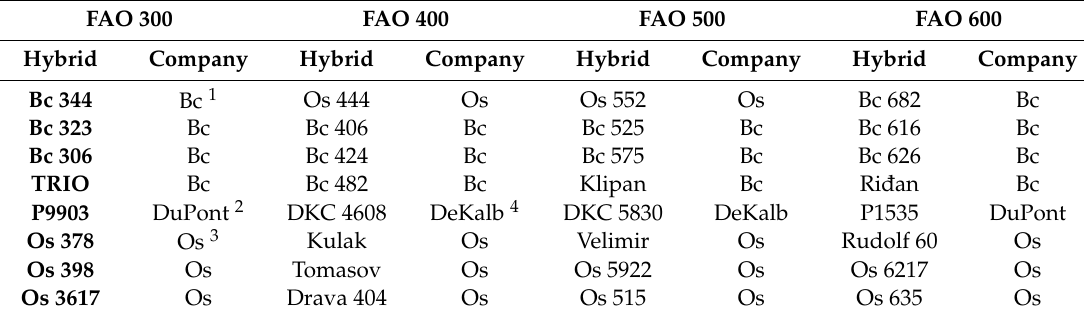
Table 7. List of the maize hybrids involved in the